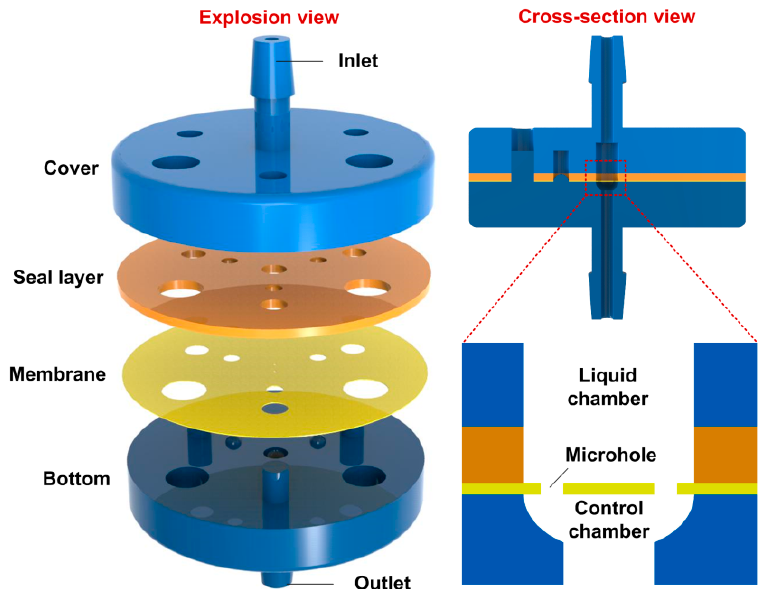
Figure 3. Schematic 3D architecture of the microfluidic passive valve. The explosion view shows the four parts of the valve, and the cross-section view shows the inner structure of the valve.